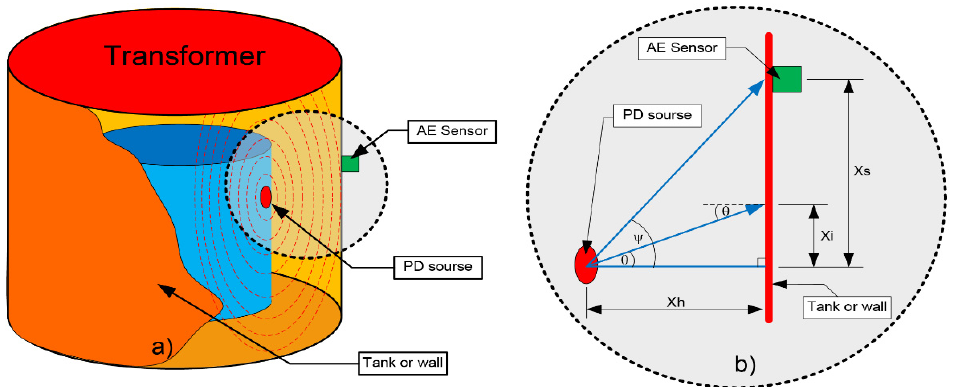
Figure 1. the relationship between PD source and AE sensor. ( a ) Radical PD sound wave Figure 1. The relationship between PD source and AE sensor. ( a ) Radical PD sound wave propagation propagation patterns. ( b ) various parameters characterizing PD wave propagation paths [14]. patterns. ( b ) various parameters characterizing PD wave propagation paths